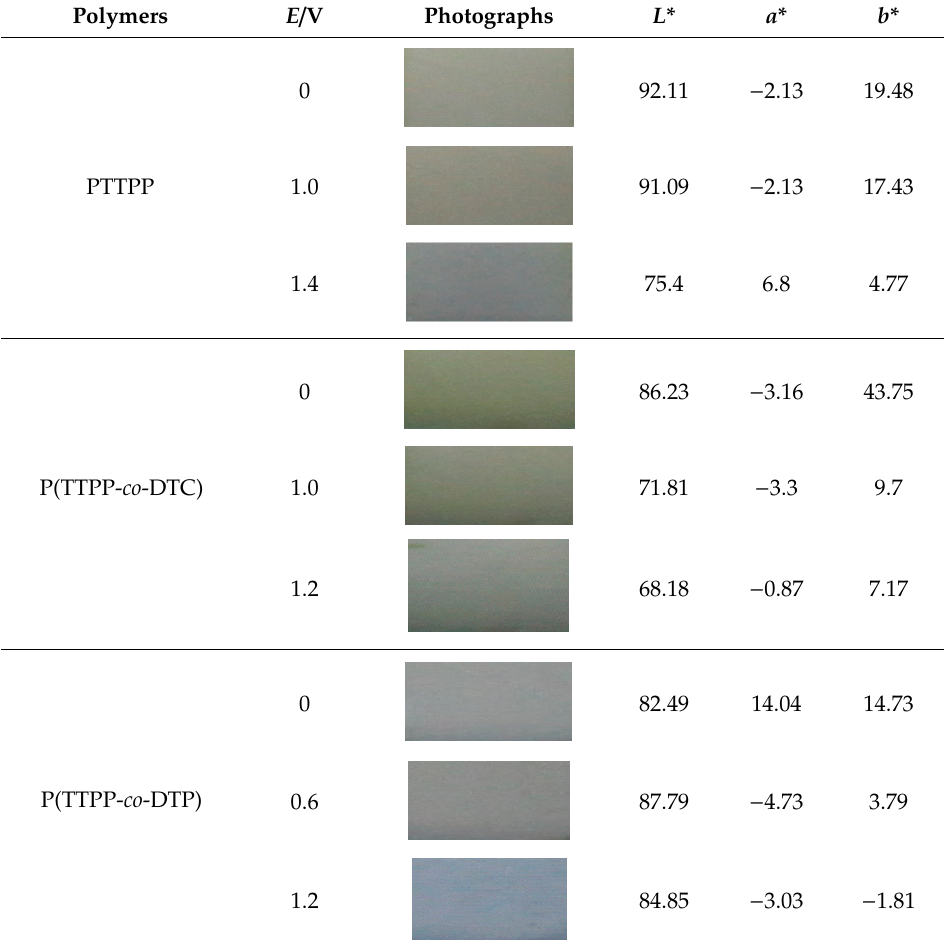
Table 1. Electrochromic behaviors of Table 1. Electrochromic behaviors of PSNS. Table 1. Electrochromic behaviors of PSNS. Table 1. Electrochromic behaviors of PSNS. Table 1. Electrochromic behaviors of PSNS. Table 1. Electrochromic behaviors of PSNS. Table 1. Electrochromic behaviors of PSNS. Table 1. Electrochromic behaviors of PSNS. Table 1. Electrochromic behaviors of PSNS. Table 1. Electrochromic behaviors of PSNS.